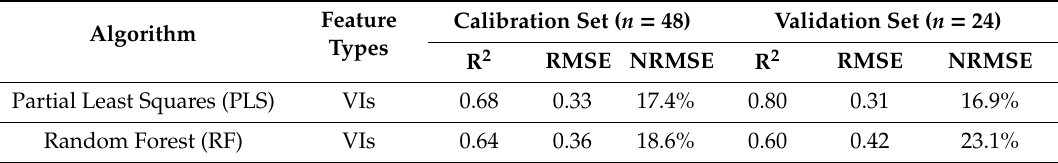
Table 6. Modeling results between VIs and LNC.